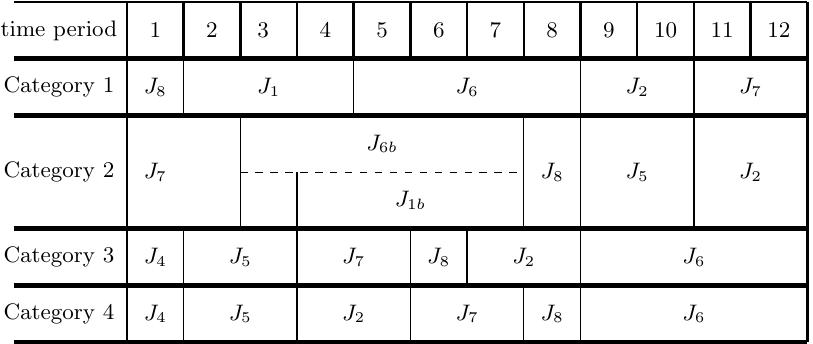
Figure 1: A schematic representation of the optimal schedules for the four categories of schedul- ing